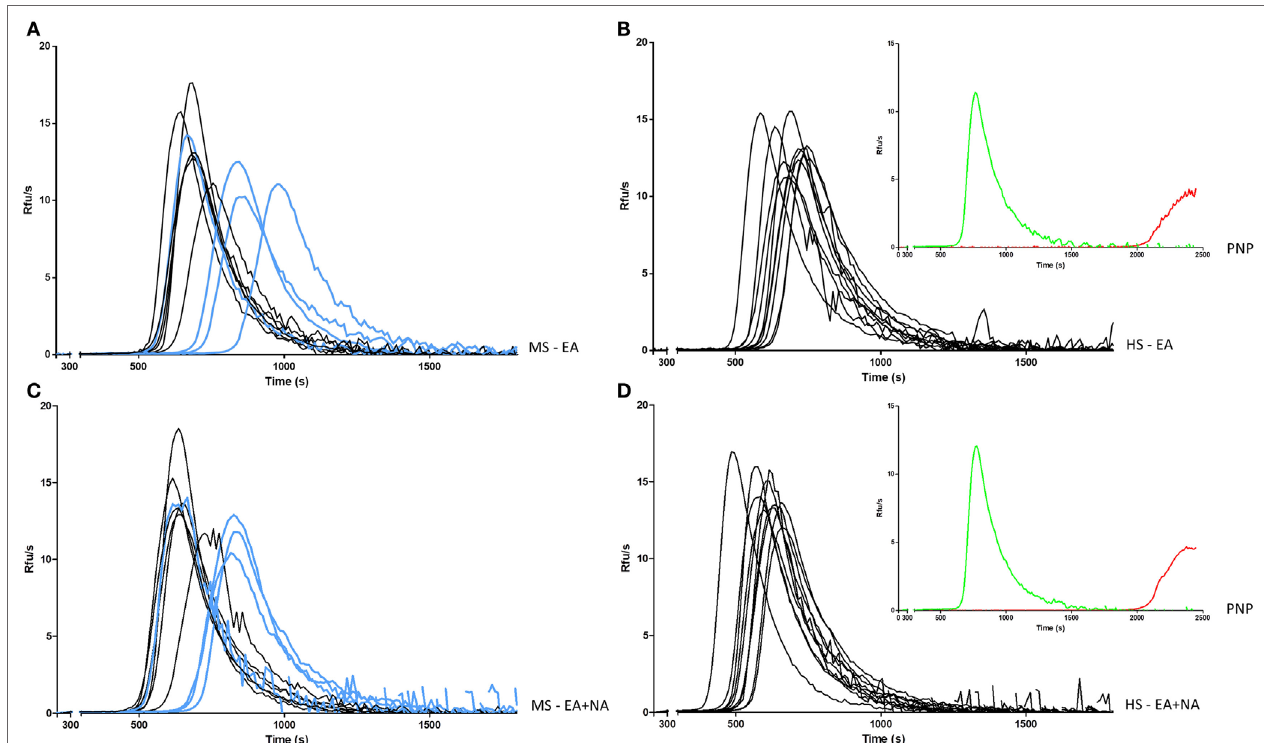
FigUre 1 | Intrinsic generation of thrombin in plasma of MS patients and HS. Thrombin generation activity in plasma samples was triggered by EA in MS patients (a) and in HS (B) , or EA plus NA in MS patients (c) and in HS (D) . Curves from PP-MS are shown in light blue. Curves of PNP (insets) in the same conditions of MS patients and HS (green), and after addition of FXII inhibitor (red) are reported as control. MS, multiple sclerosis; PP-MS, primary progressive multiple sclerosis; HS, healthy subjects; EA, ellagic acid; NA, nucleic acid; PNP, pooled normal plasma; RFUs, relative fluorescence units; s,